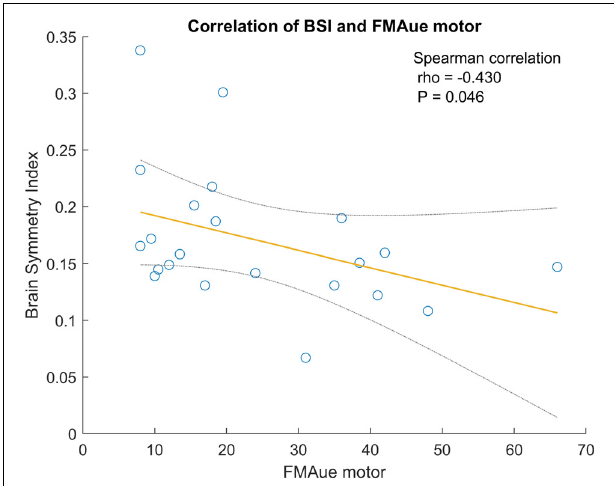
relationship is − 0.430 and P = 0.046. Lower BSI values are related to better